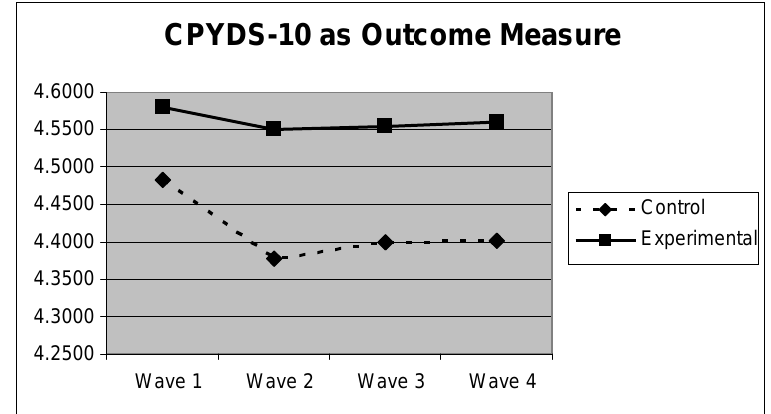
FIGURE 7. Growth trajectories in the experimental participants participating in the Tier 1 Program (and who regarded the program as beneficial) and control participants using CPYDS-10 as an outcome indicator.